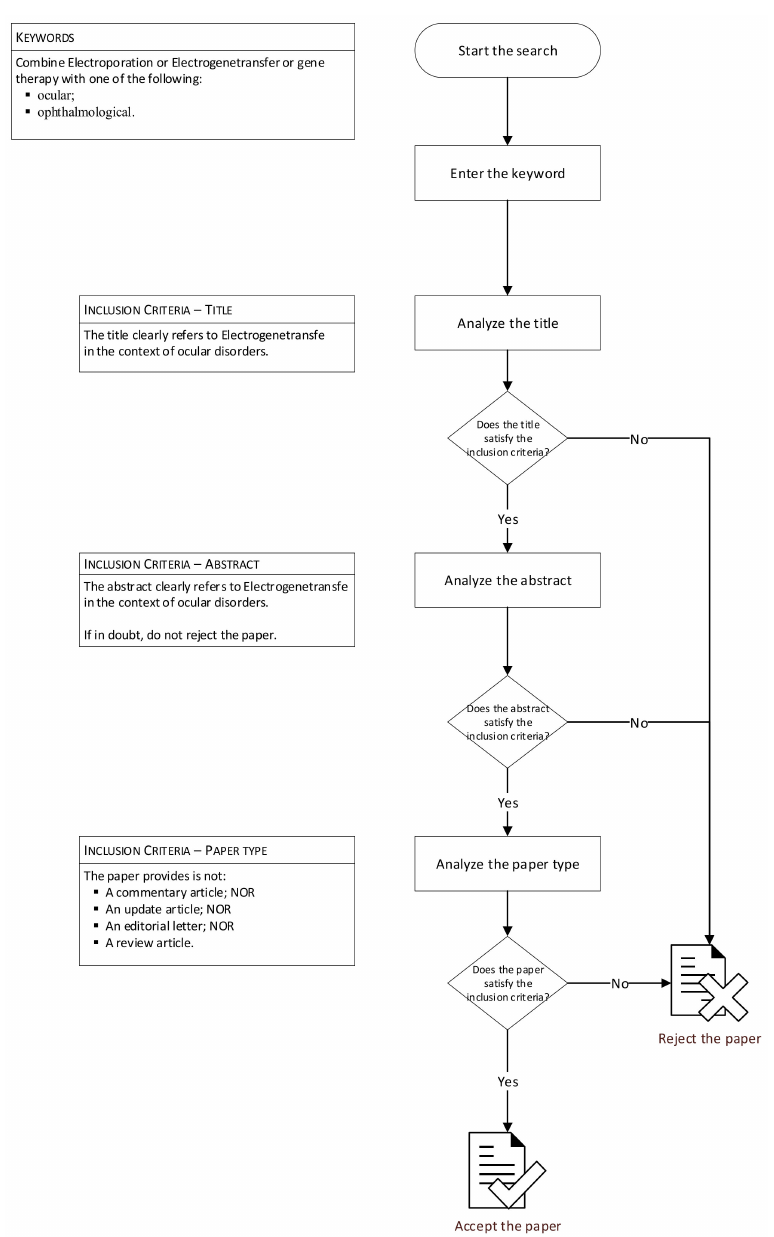
Figure 2. Flowchart of research